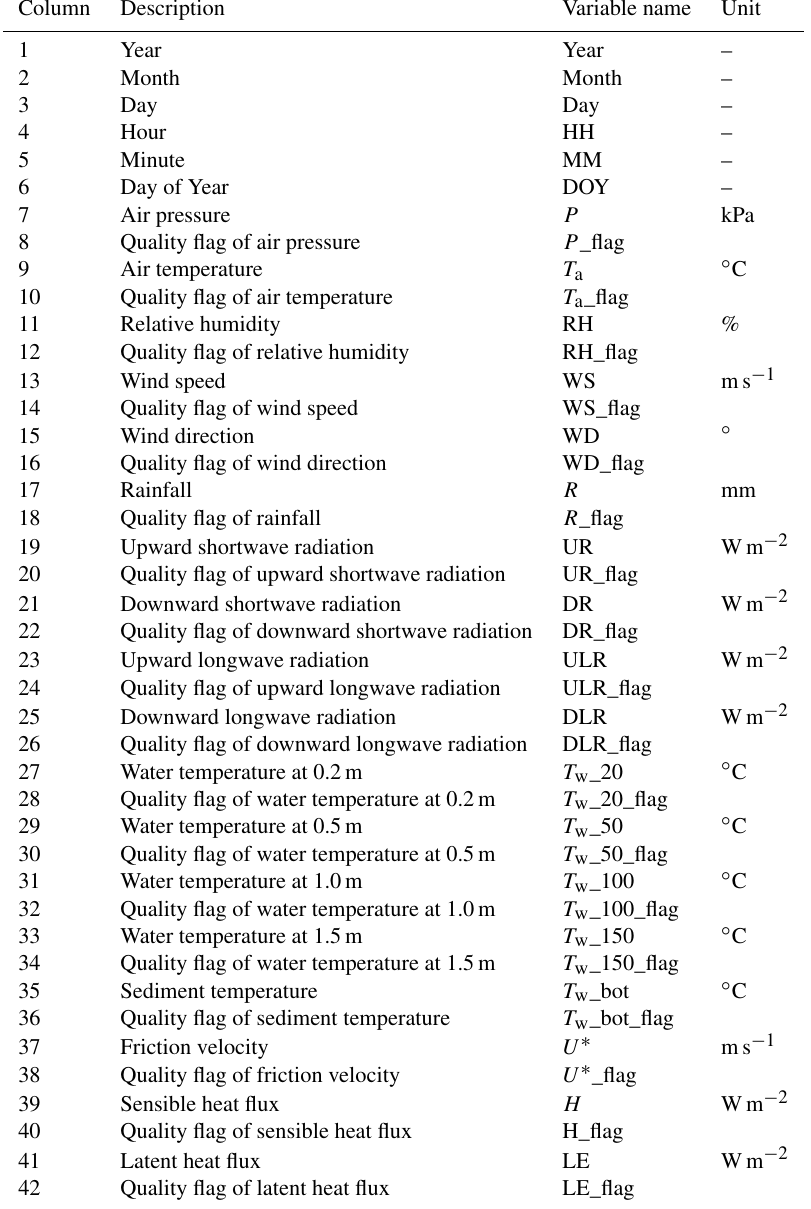
Table 4. A list of data columns and variable definitions.